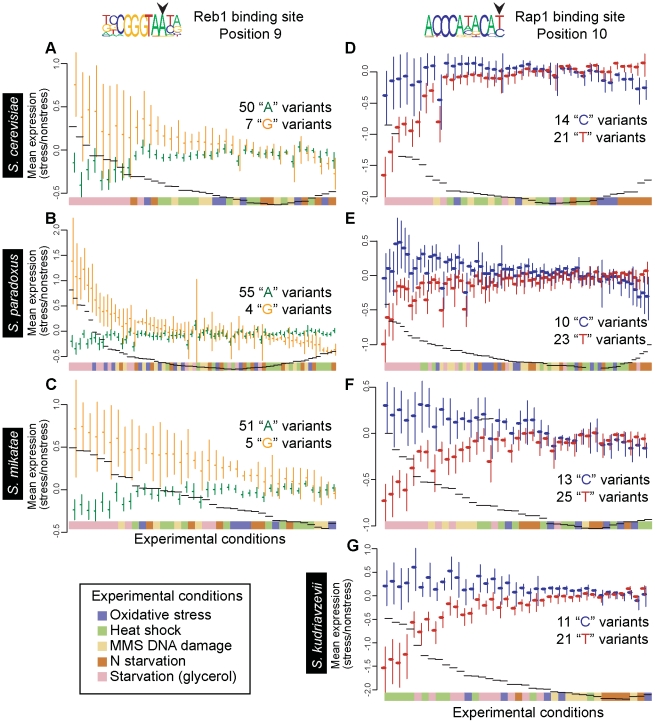
Conserved expression patterns associated with functional binding site motif variants (BSMVs).The y-axis of each plot is the mean expression (Y6.4kv6 arrays) standard error of mean shown) of the stress condition relative to the non-stress condition and the x-axis is experimental treatment, ordered by the difference between the means of genes with each BSMV (black dashes). The function of variant nucleotides at position 9 of the Reb1 binding motif is conserved in (A) Saccharomyces cerevisiae, (B) S. paradoxus, and (C) S. mikatae. In all three species, genes associated with the “G” BSMV (orange) are more highly expressed than genes associated with the “A” BSMV (green) in starvation conditions (glycerol). The function of variant nucleotides at position 10 of the Rap1 binding motif is conserved in (d) S. cerevisiae, (e) S. paradoxus, (f) S. mikatae, and (g) S. kudriavzevii. In all four species, genes associated with the “C” BSMV (blue) are more highly expressed than genes associated with the “T” BSMV (red) in starvation conditions (glycerol), and the opposite relationship is apparent during nitrogen starvation. The expression differences between the BSMVs are significantly condition-specific in panels a-f (p<0.005).